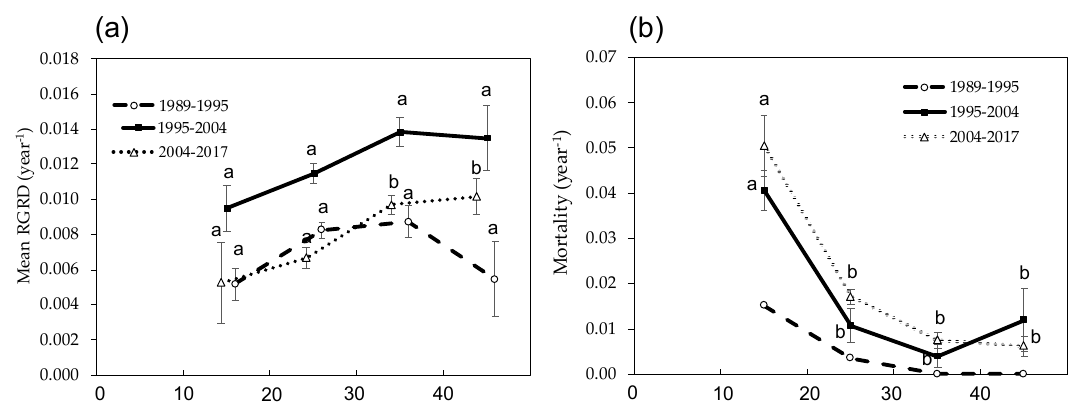
Figure 4. ( a ) mean relative growth rate of DBH (RGRD) of Castanopsis cuspidata in each measuring interval; ( b ) mortality of each DBH class of C. cuspidata in each measuring interval. The DBH class of the stems is the beginning of each measuring interval (the DBH ≥ 40 cm class includes several stems of DBH ≥ 50 cm.). Error bars indicate SE (Stand Error) of the means and the letters indicate significant differences among DBH classes in each measuring interval ( p < 0.05) . Because the tree map was made during 1995, we could not check the location of some trees that dies during 1989–1995; therefore, the statistical difference of mortality during the 1989–1995 period was not assessed.